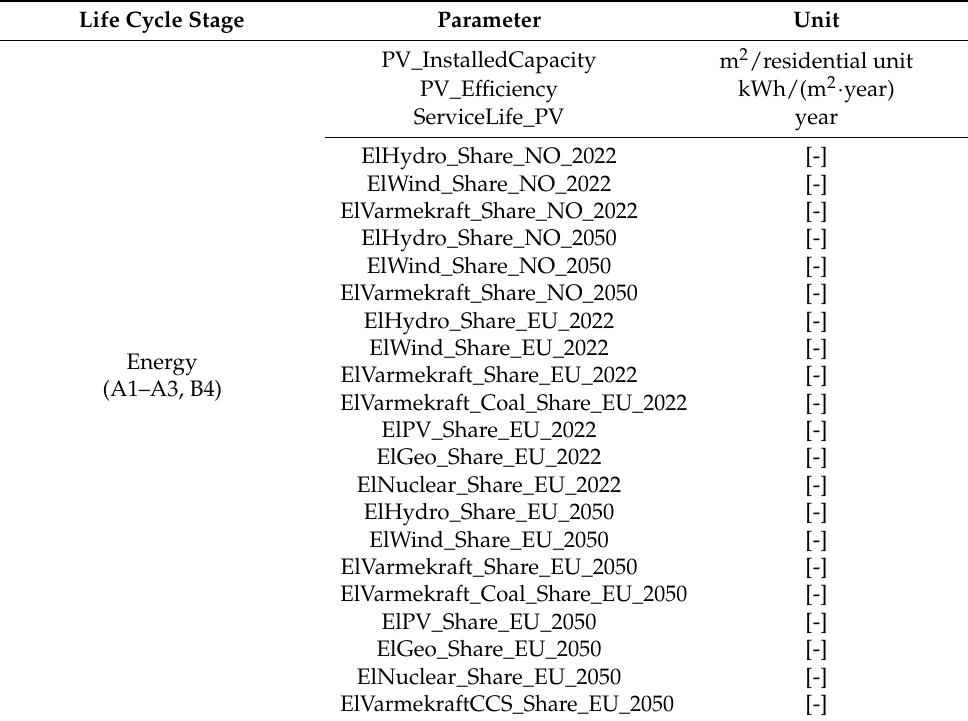
Table A3. List of parameters for the neighborhood sub-element